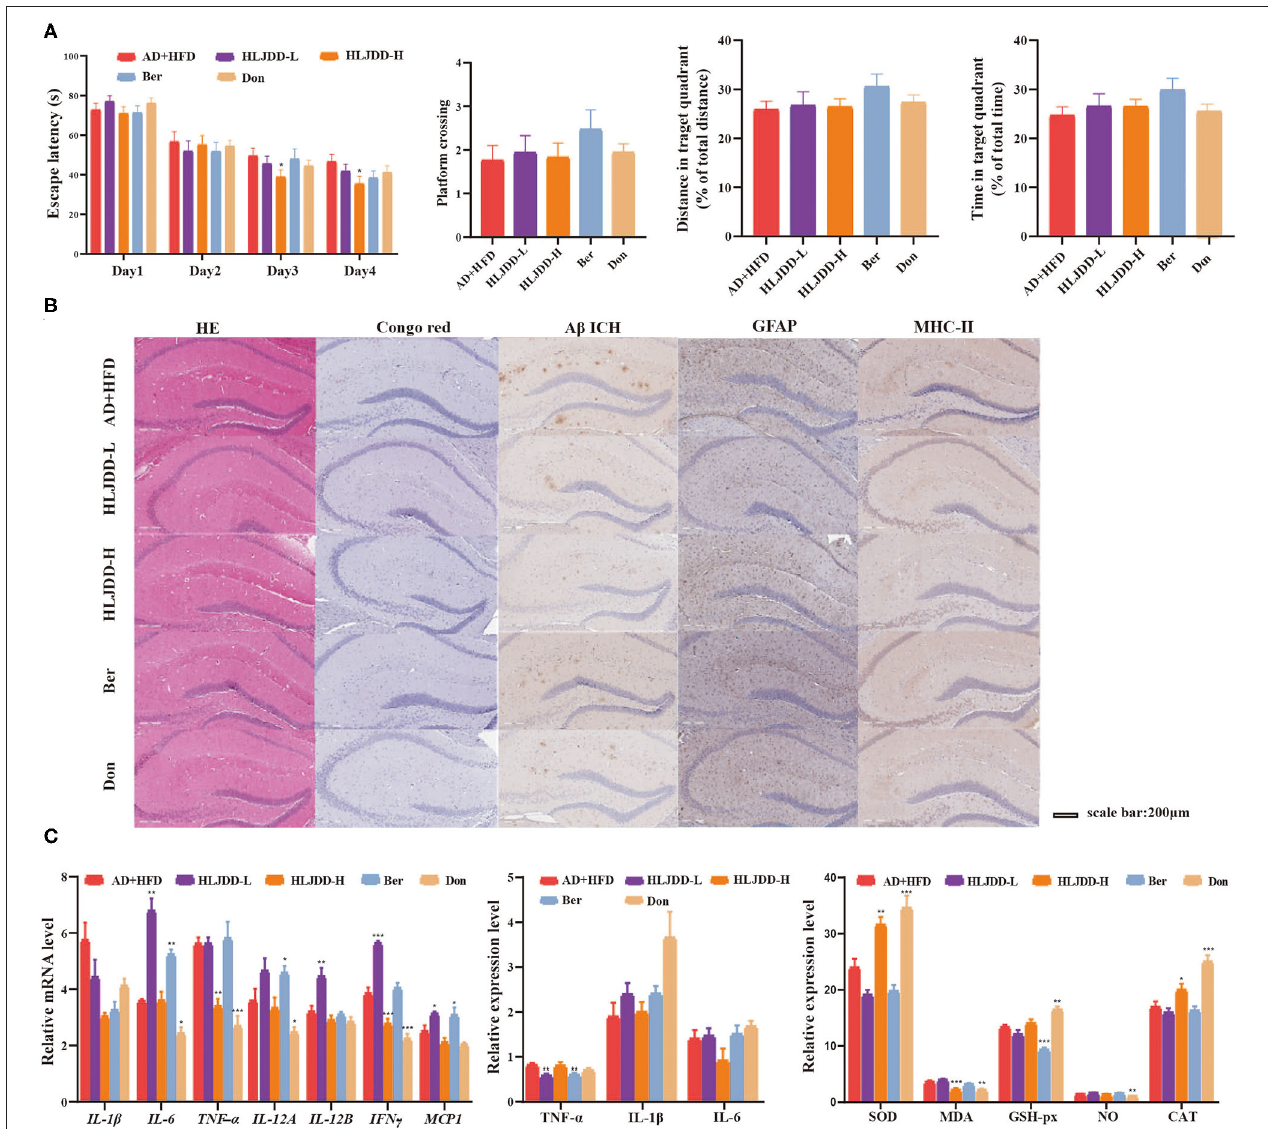
FIGURE 6 | The effect of HLJDD on high fat diet treated APP/PS1 mice. Escape latency during spatial acquisition training (A) , the platform crossing number, distance traveled percentage in the target quadrant and time spent percentage in the target quadrant in the spatial probe test. (B) The HE and Congo red stain in mice brain tissue, A β deposition, the level of GFAP, and MHC class II in brain tissue detected by immunohistochemical method. (C) The expression of inflammatory cytokine detected by RT-PCR and Elisa method, respectively. And the indicators of oxidative stress in brain tissue. * p < 0.05, ** p < 0.01, *** p < 0.001 (compared to AD + HFD